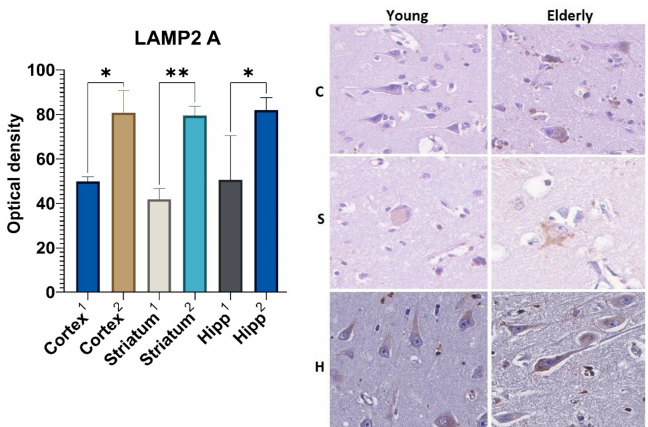
Figure 3. Results of LAMP2A immunohistochemical staining: 1—young group, 2—elderly group; C—cortex, S—corpus striatum, H—hippocampus. *—differences are statistically significant ( p < 0.05). **—differences are statistically significant ( p < 0.001). Magnification 400 ×